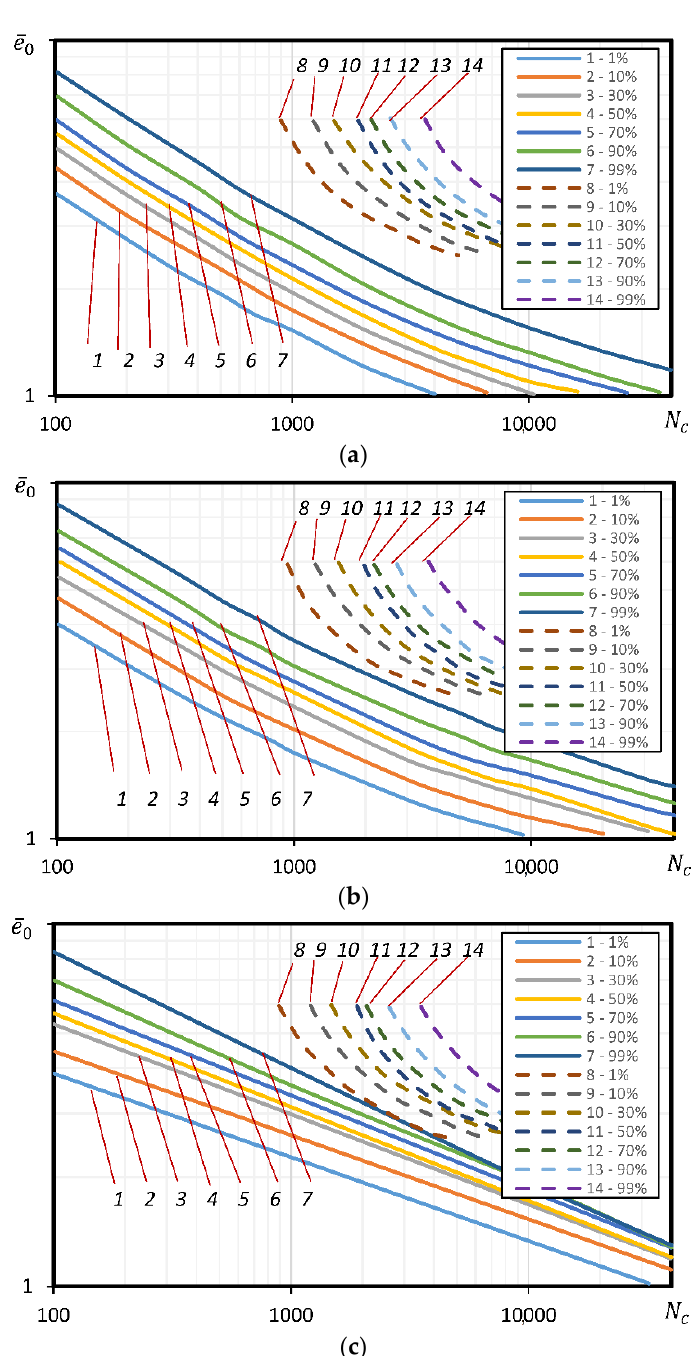
Figure 10. Comparison of the experimental (dashed lines) and theoretical (straight lines) curves for the C45 steel under loading with controlled strain (1–7 = analytical probability, 1–99%; 8–10 = experi- mental probability, 1–99%): ( a ) according to the Coffin dependency (Equation (11)); ( b ) according to the Manson–Langer dependency (Equation (13)); ( c ) according to PNAE rules (Equation